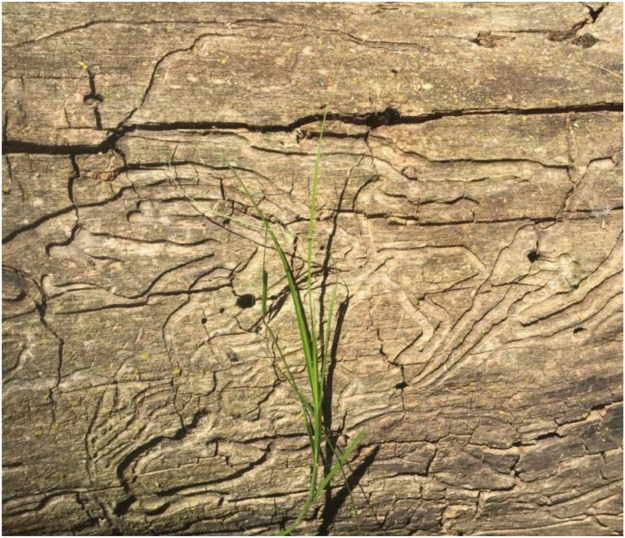
Serpentine gallery found on Green Ash identified as native borer species by UNL entomologist.